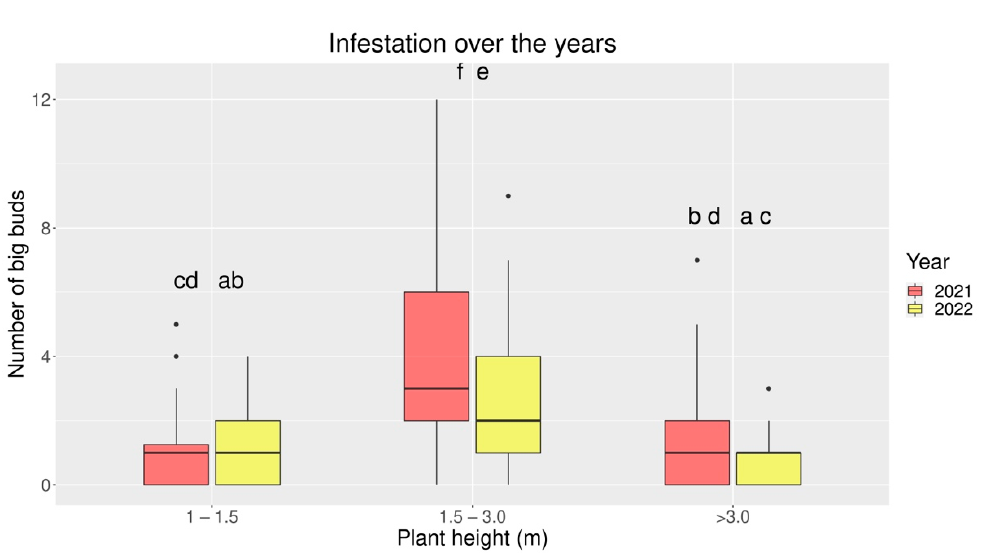
Figure 4. Overall infestation of hazelnut plants over the band heights, distinguishing between 2021 and 2022. Different letters indicate significant difference between the year of survey and height ranges after Bonferroni post hoc test at p < 0.05.